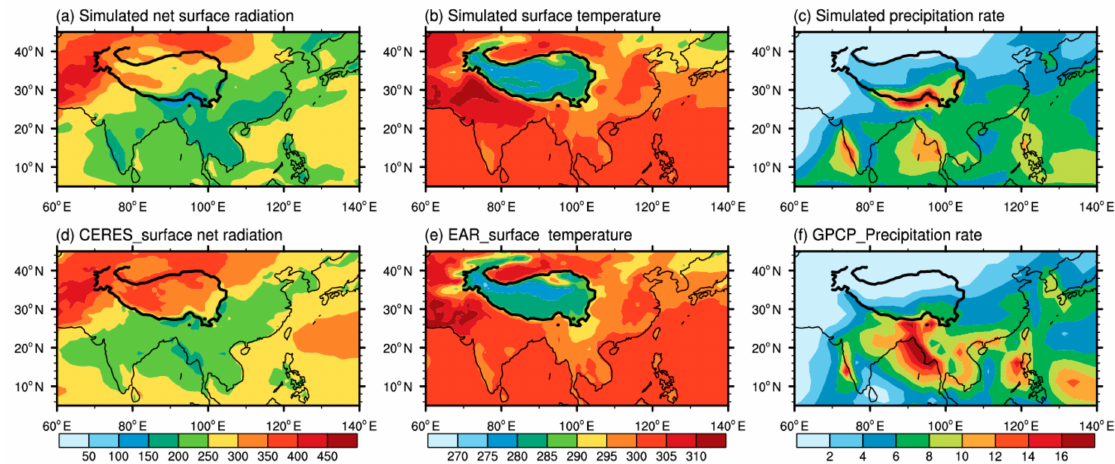
Figure 2. Evaluations of simulated summer all sky net surface radiation (W / m 2 ), surface temperature (ST) (K) and precipitation rate (mm / day) by the Community Earth System Model (CESM) model for the period from 2001–2005. Where, ( a – c ) are model simulations, while the ( d – f ) are derived from the data of CERES, EAR-interim and the Global Precipitation Climatology Project (GPCP), respectively. The down direction in ( a ) and ( d ) is defined as the positive value, otherwise the upward direction is defined as the negative value. The area of the Tibetan Plateau (TP) is enclosed by a black